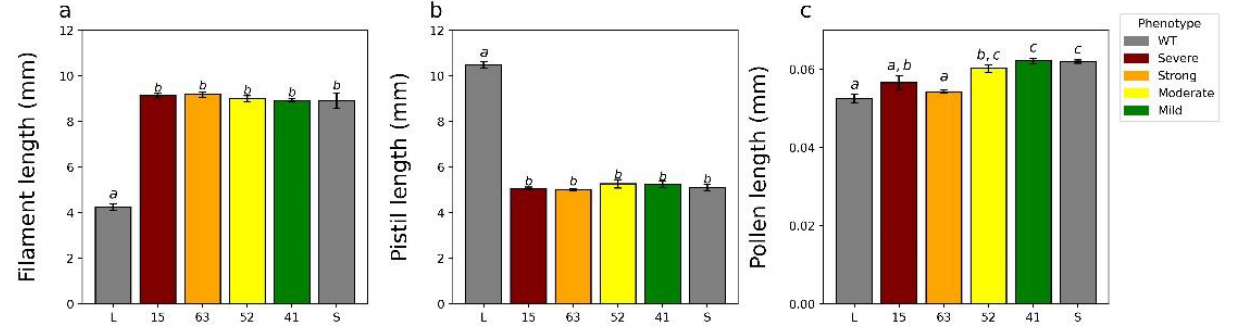
Figure 4. Quantification of the relevant floral characteristics of the T 0 ( a – c ). For all analyses, means sharing the same letter are not significantly different following a single factor ANOVA and Tukey’s test. a, filament length; b, pistil length; c, pollen length. Error bars represent the standard error. Length of the pistils of three flowers ( a ) F 5,12 = 277.5, p < 0.0001, N = 9 pistils, 3/flower; length of the filaments of three flowers ( b ) F 5,12 = 120.3, p < 0.0001, N = 15 filaments, 5/flower; and mean length of pollen grains from three flowers ( c ) F 5,12 = 17.1, p < 0.0001, N = 300 pollen grains, 100/flower.